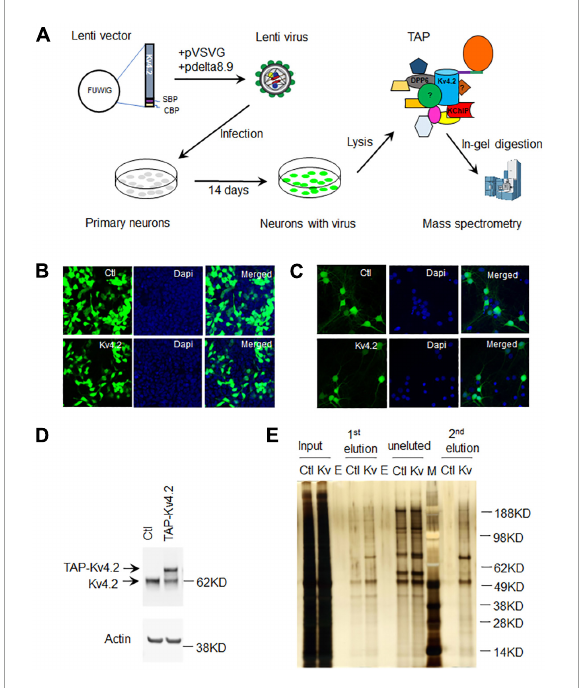
FIGURE2 Purification of Kv4.2 protein complex using TAP in culture hippocampal neurons. (A) Schematic diagram of Kv4.2 protein complex purification using TAP in cultured hippocampal neurons. (B) Lentivirus expression of GFP or TAP-Kv4.2 plus GFP in HEK293FT cells (DIV 5). (C) Lentivirus expression of GFP or TAP-Kv4.2 plus GFP in hippocampal neurons (DIV10 after infection). (D) Western blot showing TAP-Kv4.2 expression in DIV14 hippocampal neurons. (E) Silver staining showing purified TAP-Kv4.2 protein complex in DIV14 hippocampal neurons. Note that there are plenty of non-specific proteins in control TAP purification after streptavidin resin pulldown (1st elution), while non-specific proteins are not visible after calmodulin resin pulldown (2nd elution), demonstrating the effectiveness of TAP in cultured hippocampal neurons. E, empty; M,